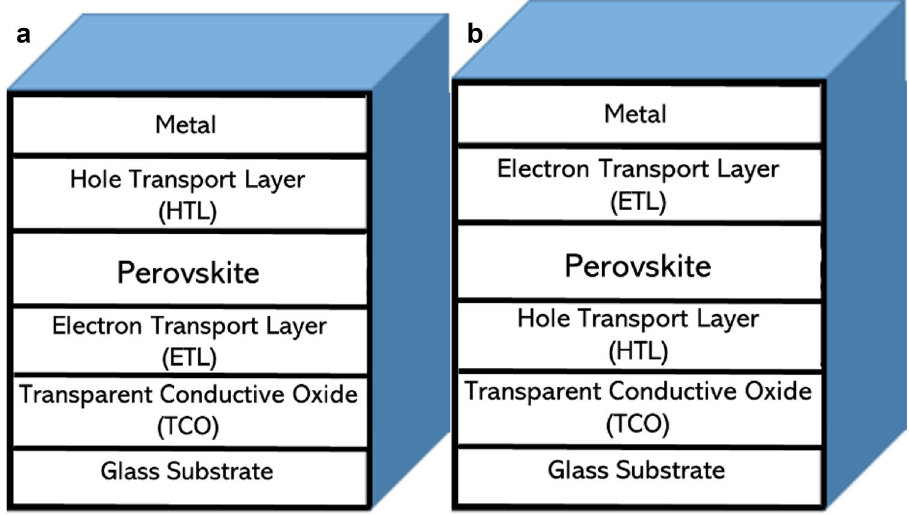
Fig. 1 Perovskite solar cell: a n–i–p planer regular architec- ture and b p–i–n inverted planer